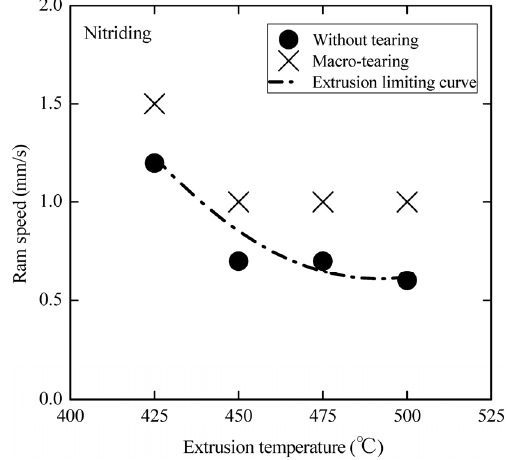
Fig. 12 Extrusion limit diagram for tearing of A7075 alloy using the dies with different coatings.